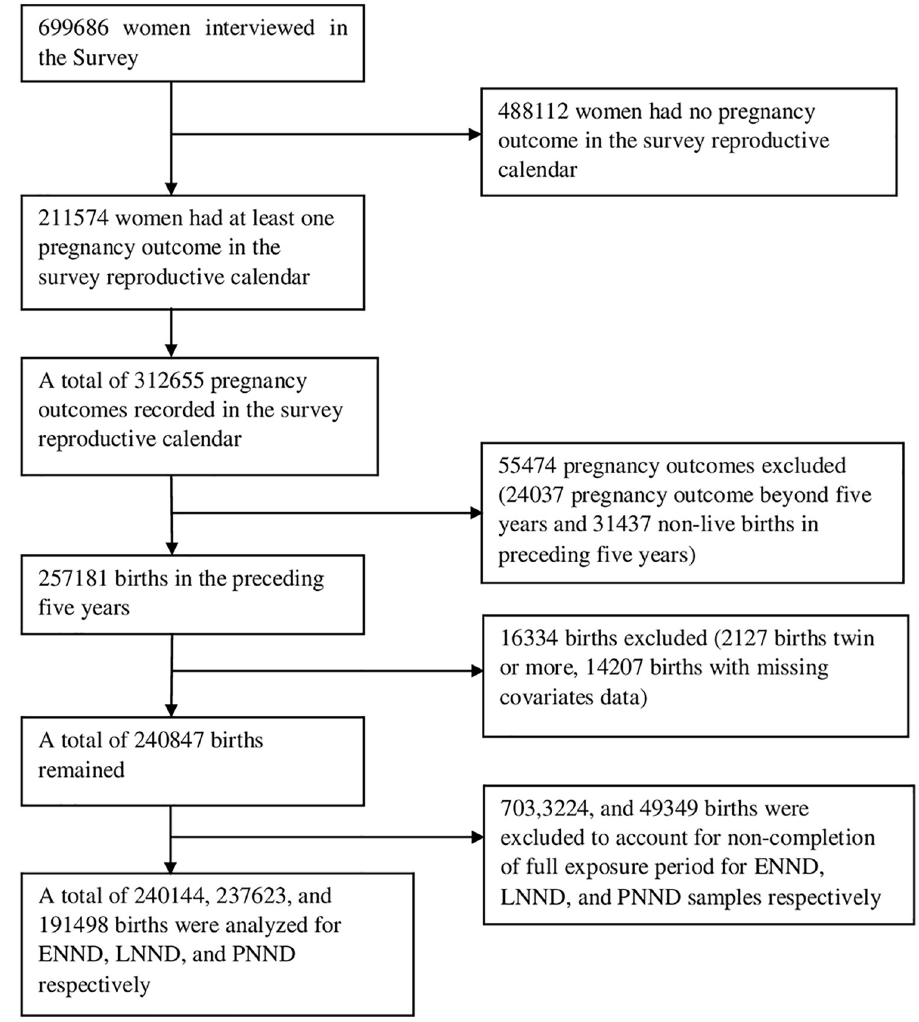
Fig 2. Sample selection